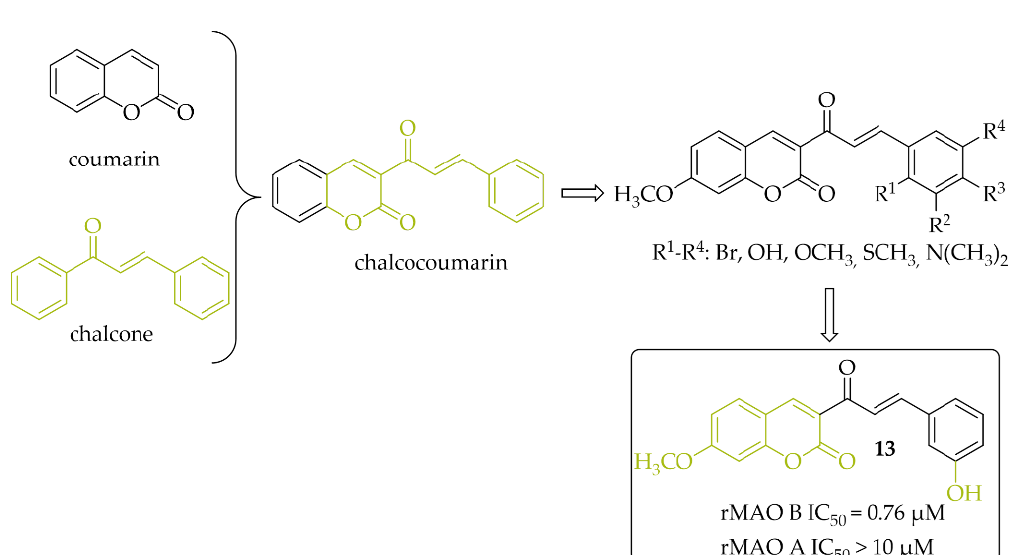
Figure 11. Chalcocoumarin hybrids and the most potent compound in the series [32].